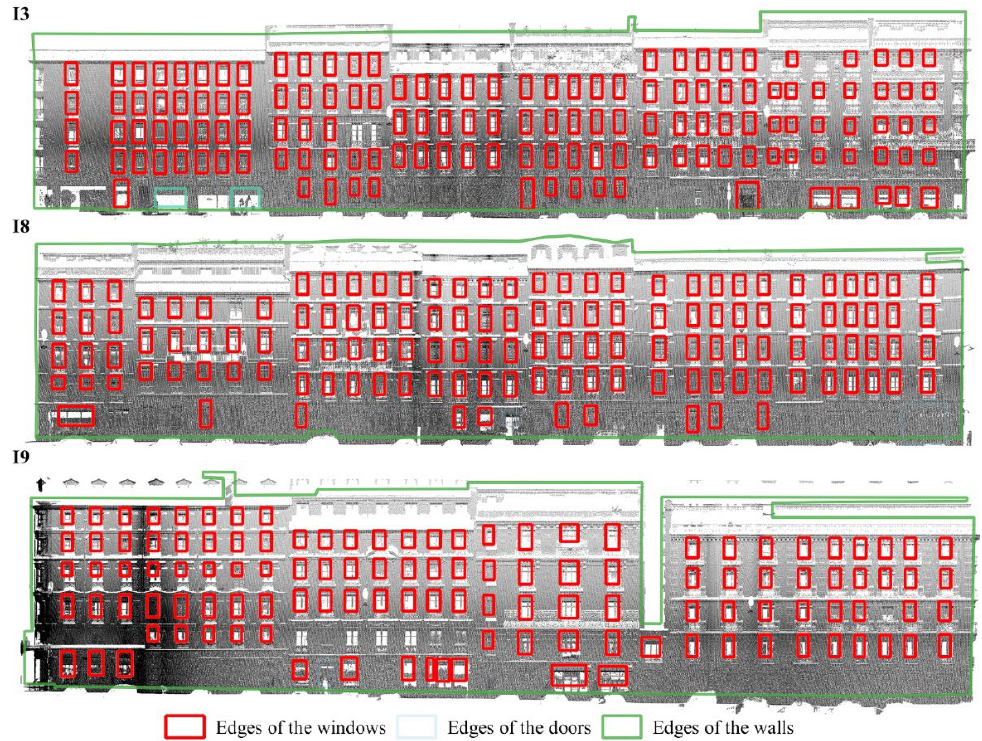
Figure 11. Facade map extraction with the IQmulus & TerraMobilita Contest dataset: the number in the upper left corner corresponds to the facade number in Figure 9; the red, blue, and green lines in the figure represent the window, door, and building boundaries, respectively; and the background image shows the single-band feature image, and the darker the image pixel color, the greater the number of points contained in the corresponding planar grid. Table 2. Accuracy of window extraction for the IQmulus & TerraMobilita Contest